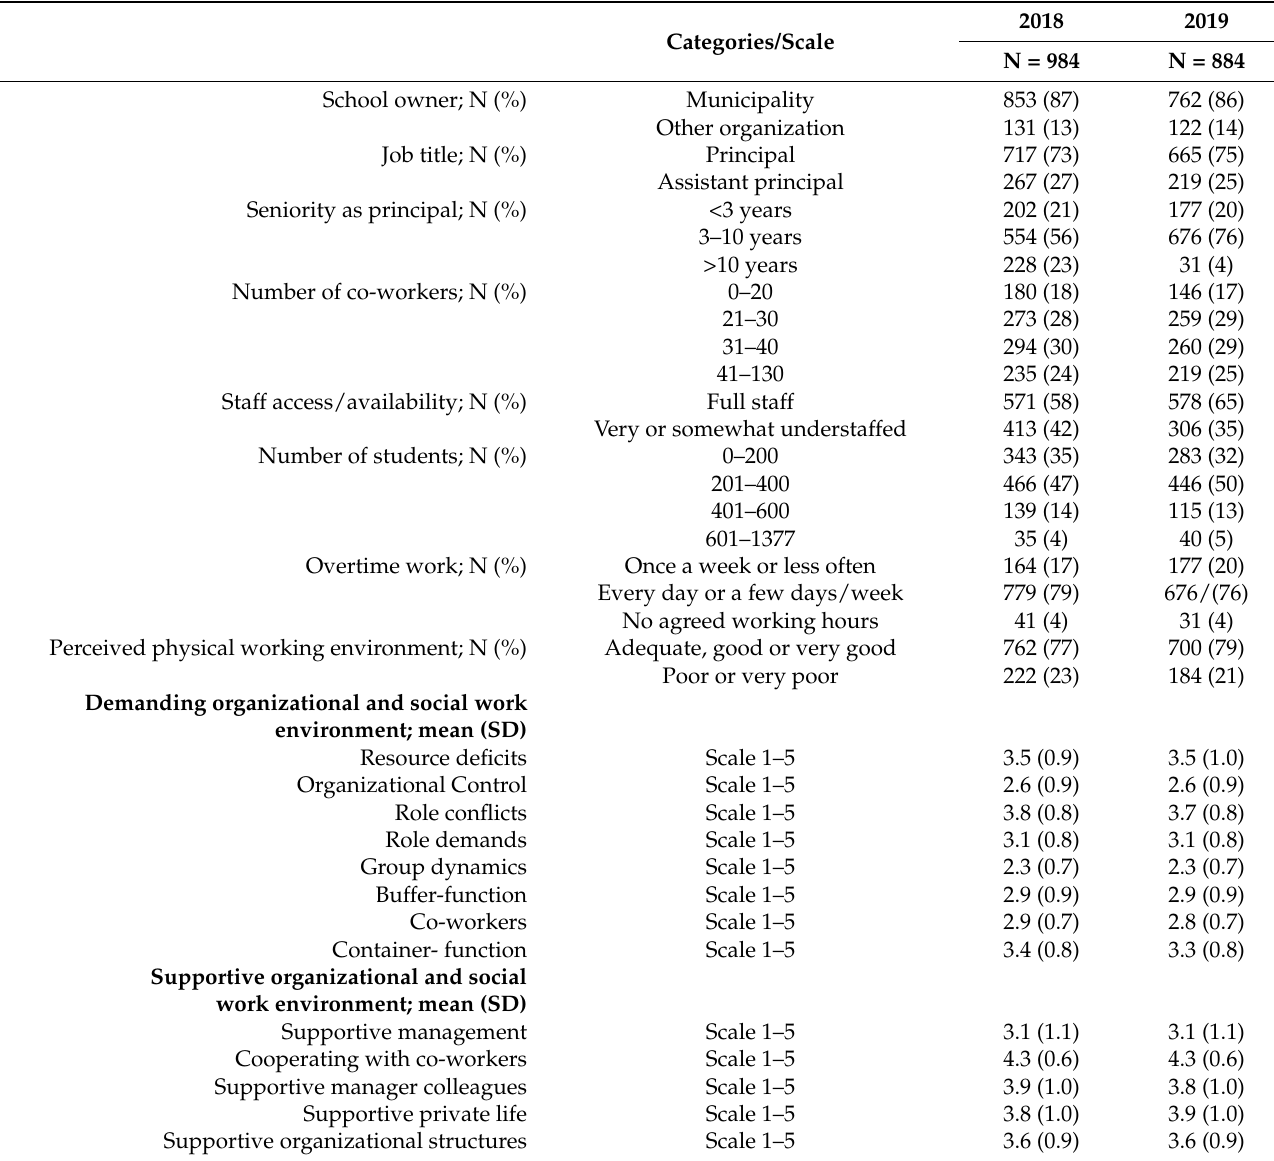
Table 1. Characteristics among participants included in Part I of the study, regarding reported conditions at work in the years 2018 (N = 984) and 2019 (N = 884). The number of participants who responded to both questionnaires was